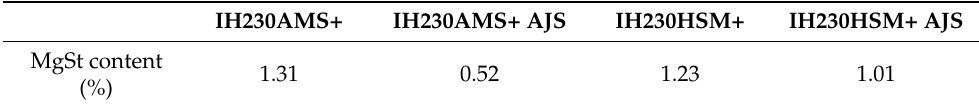
Table 3. Additive content before and after the removal of residual particles (AJS). n = 1.